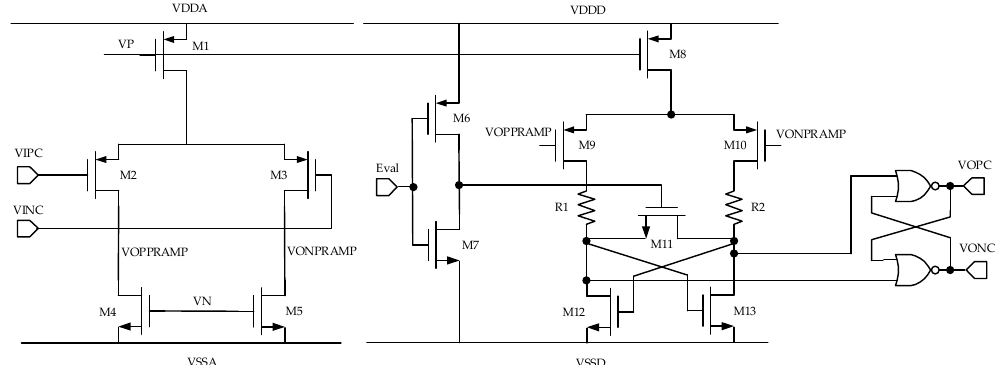
Figure 8. The circuit of the comparator.